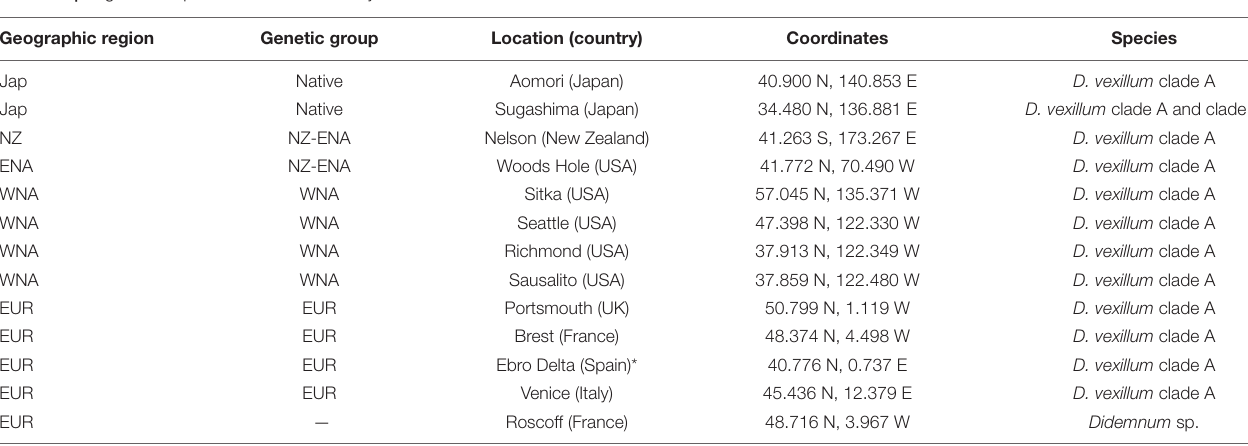
TABLE 1 | Origin of samples for microbiome analyses. Geographic